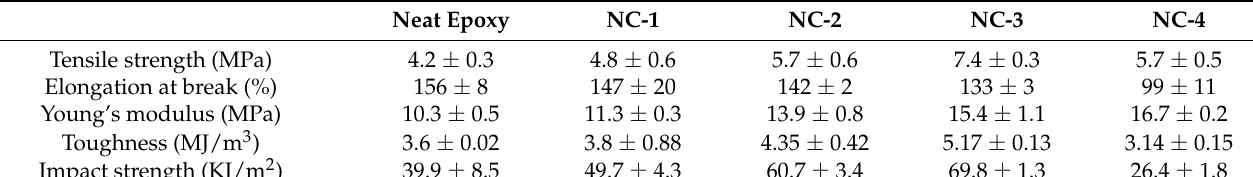
Figure 5. ( a ) Shear-rate dependency of the complex viscosity of neat epoxy and the fumed silica composites and ( b ) the filler loading dependence of tan δ measured at 1 rad/s. Table 1. Mechanical properties of neat epoxy and nanocomposites.